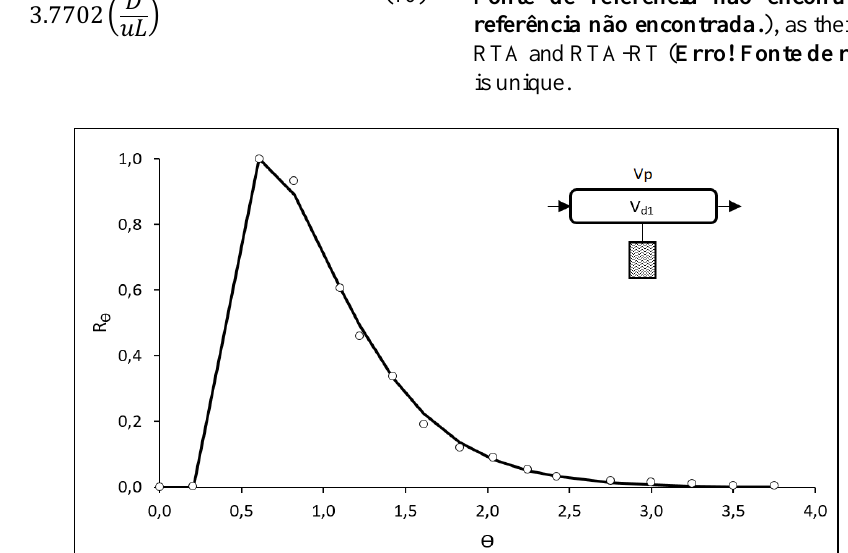
Figure 2: RTD curve for the tubular reactor with R 2 = 0.99, being (o) the experimental data and (-) the proposed model.